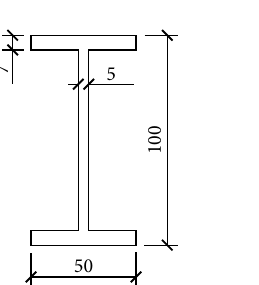
Figure 18: Comparison with #C2.